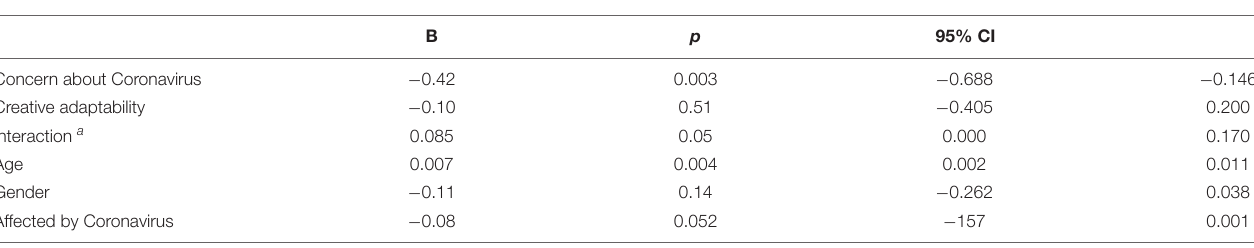
TABLE 4 | Concern about Coronavirus predicting well-being moderated by creative